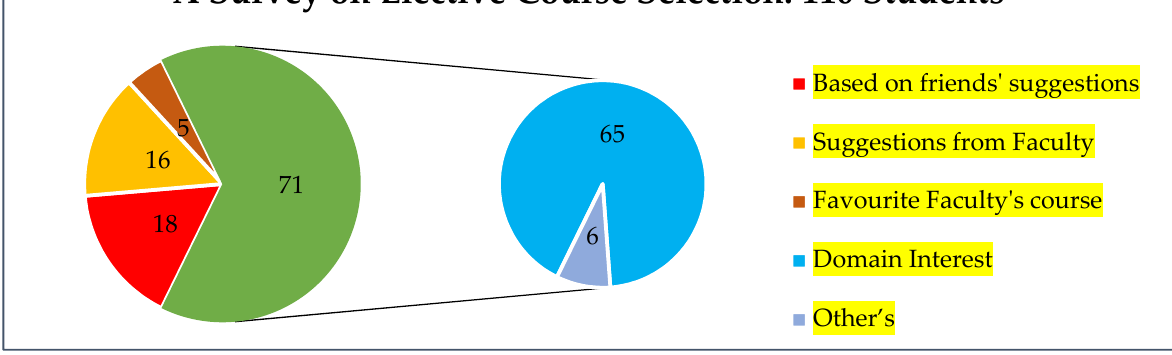
Figure 1. A survey on the selection of elective courses.